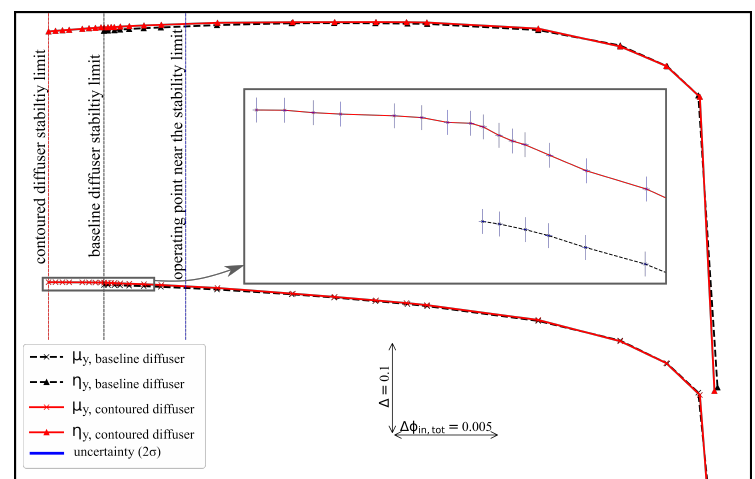
Figure 6. Performance characteristics at stage Mach number Mu 2 = 1.16.